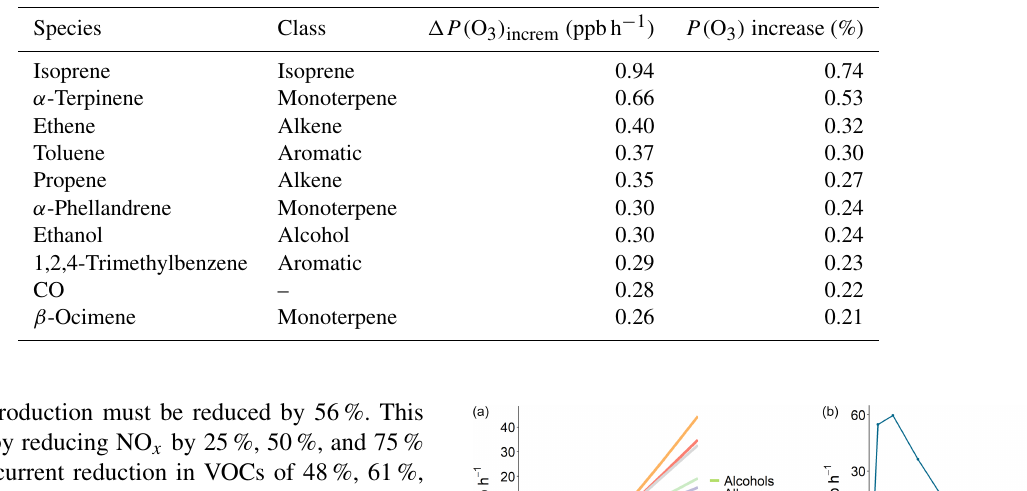
Table 1. The top 10 highest (cid:49)P( O 3 ) increm VOCs, and their respective classes, averaged between 08:00 and 12:00.